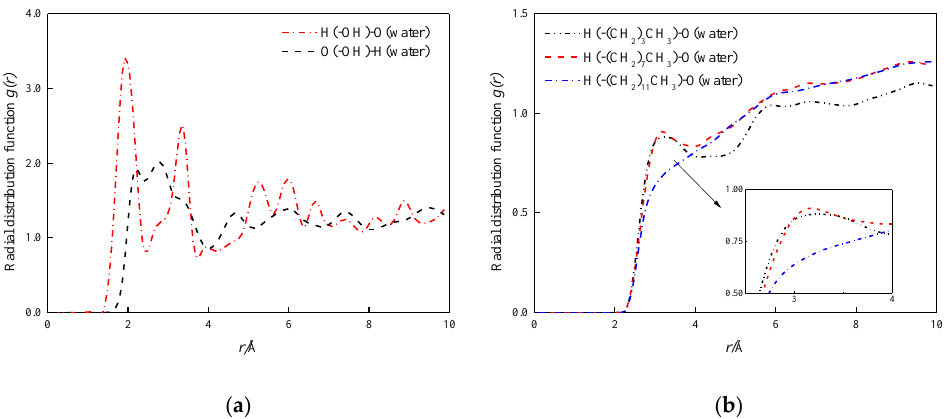
Figure 10. H-bonds radial distribution function at solid–liquid interface. ( a ) H-bonds radial distribution function at solid–liquid interface in hydroxylation nanochannel; ( b ) H-bonds radial distribution function at solid–liquid interface in silanized nanochannel.